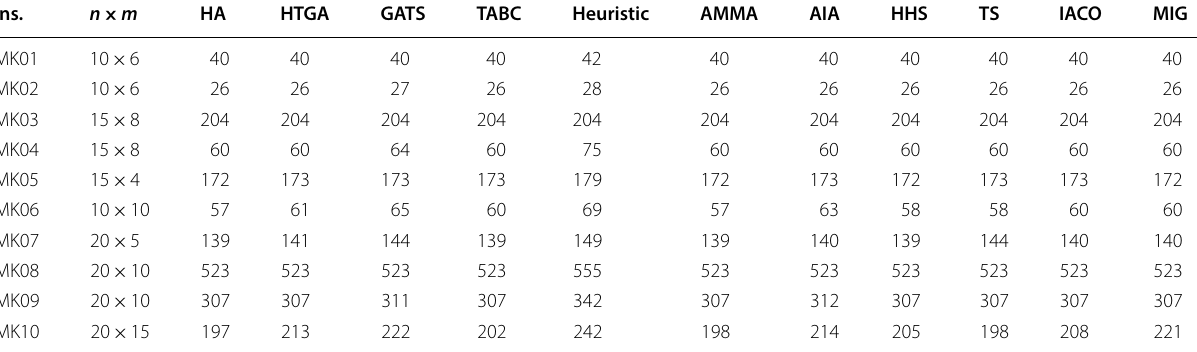
Table 5 Results of experiment 3